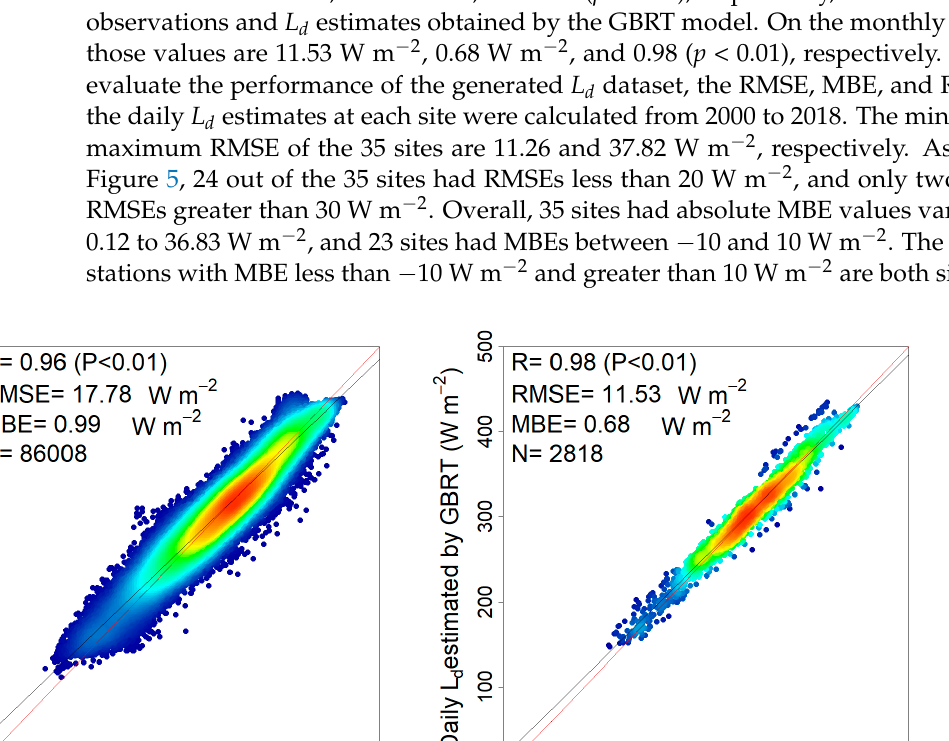
Figure 5. ( a ) RMSE and ( b ) MBE histograms of daily L d estimates with 5-km resolution based on the GBRT model against the ground measurements from March 2000 to December 2018. 4.2. Comparison with Existing L d Products To better evaluate the accuracy of the generated L d dataset, the valuation result against the 35 sites from 2000 to 2018 was compared with the CERES-SYN and ERA5 prod- ucts. The generated L d and ERA5 products were resampled to a 100-km resolution using the nearest neighbor interpolation method to match the CERES-SYN product. As shown in Figure 6, the RMSE and MBE are 17.94 and 0.25 W m − 2 , 18.81 and 1.76 W m − 2 , 18.52 and − 2.09 W m − 2 , respectively, for the daily generated, CERES-SYN, and ERA5 L d datasets. CERES-SYN and ERA5 L d show overestimated and underestimated tends on the daily time scale, respectively. Relatively speaking, the overestimated trend of the generated L d dataset with an MBE of 0.25 W m − 2 is slight. In addition, the RMSE of the ERA5 daily L d dataset is less than that of the CERES-SYN product, and it can be concluded that the ERA5 L d product over land is more accurate than that of the CERES-SYN on the daily time scale. This is consistent with the conclusion of Tang et al. [11] that the ERA5 L d product over land surface has a higher accuracy on average than the CERES-SYN on the hourly, daily,